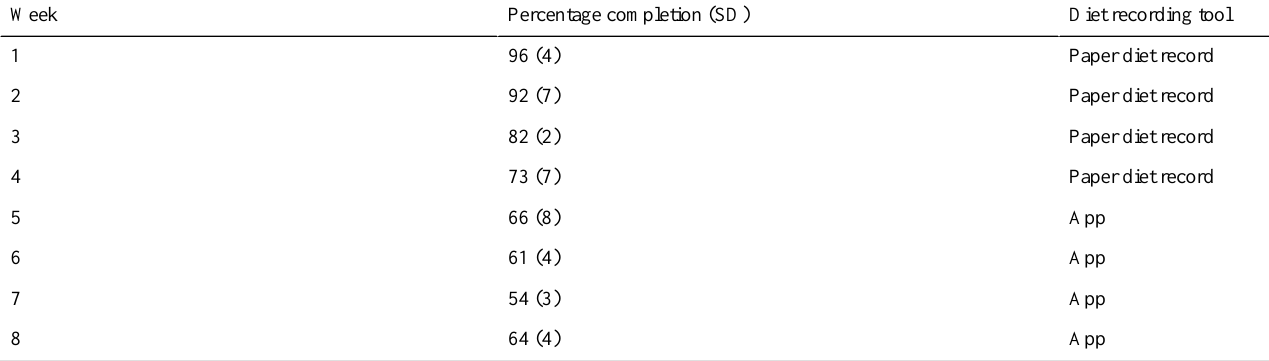
Table 2. Percentage completion of the study diary and App presented by weeks of the study. A completed day was regarded as a day with ≥ 500 kcal energy recorded [33]. SD: standard